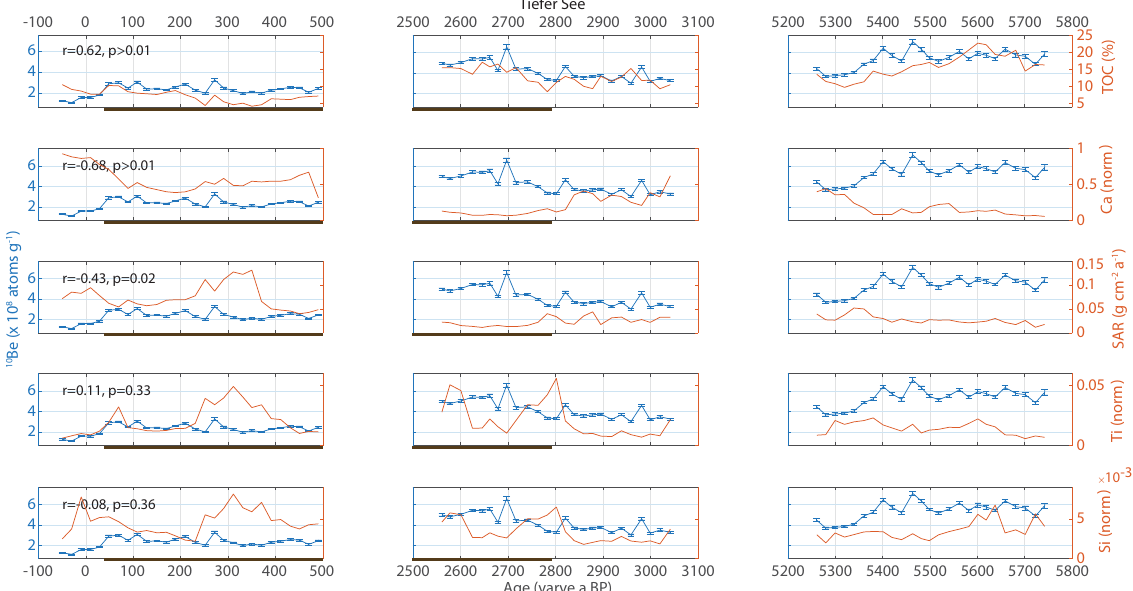
Figure 2. 10 Be concentrations ( 10 Be con ) in Tiefer See (TSK) sediments around the Maunder, Homeric and 5500aBP grand solar minima and corresponding proxy time series from the same archive. 10 Be con compared with sediment accumulation rates (SARs), total organic carbon (TOC), Ti, Ca and Si. Correlation coefficients were calculated for the complete time series covering all three grand solar minima. Significance levels of correlations were calculated using 10000 iterations of a nonparametric random phase test taking into account trend and autocorrelation present in the time series (Ebisuzaki, 1997). Error bars indicate AMS measurement uncertainties. Non-varved intervals in TSK sediments are indicated by